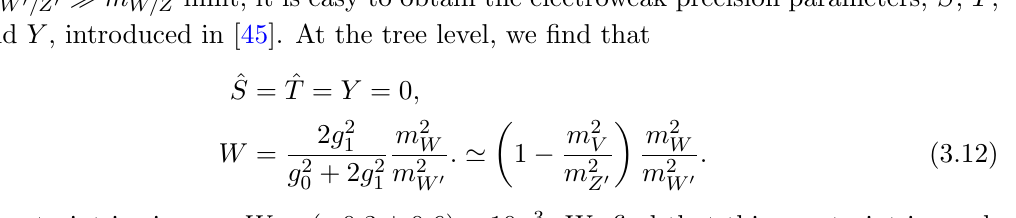
Figure 1 . The solid curve shows the lower bound on m W 0 for a given g W 0 f by recasting the result in ref. [42]. The dashed curve shows the prospect at the ATLAS experiment with 14 TeV with 3000 fb (cid:0) 1